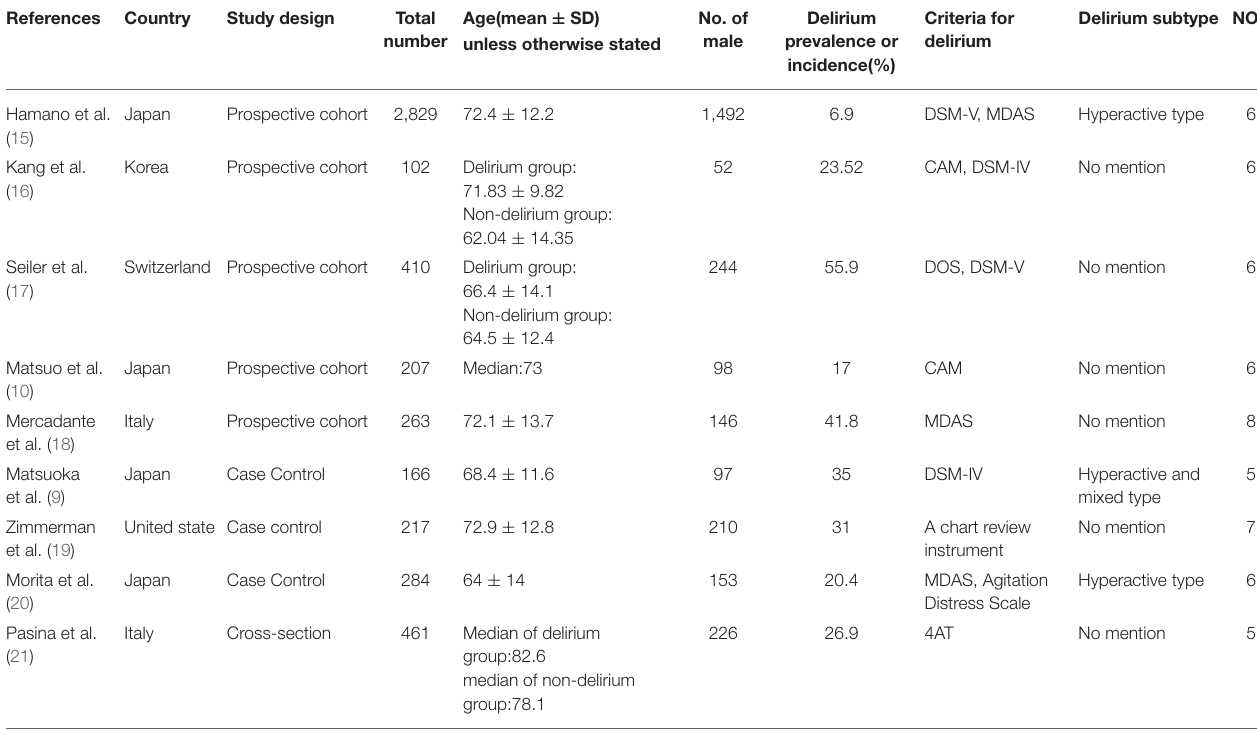
TABLE 1 | Characteristics of the included studies examining risk factors for delirium in palliative population. References Country Study design Total